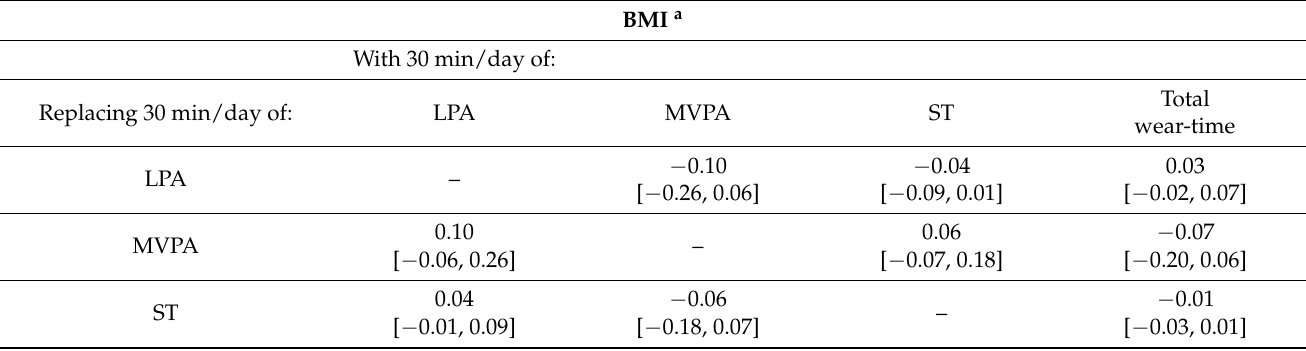
Table 4. Isotemporal substitution associations ( β [95% CI]) using 30 min reallocations between 30-month changes in non-school time LPA, MVPA, and ST and BMI, WHR, and BF% at 30-month follow-up in boys ( n = 63). BMI a With 30 min/day